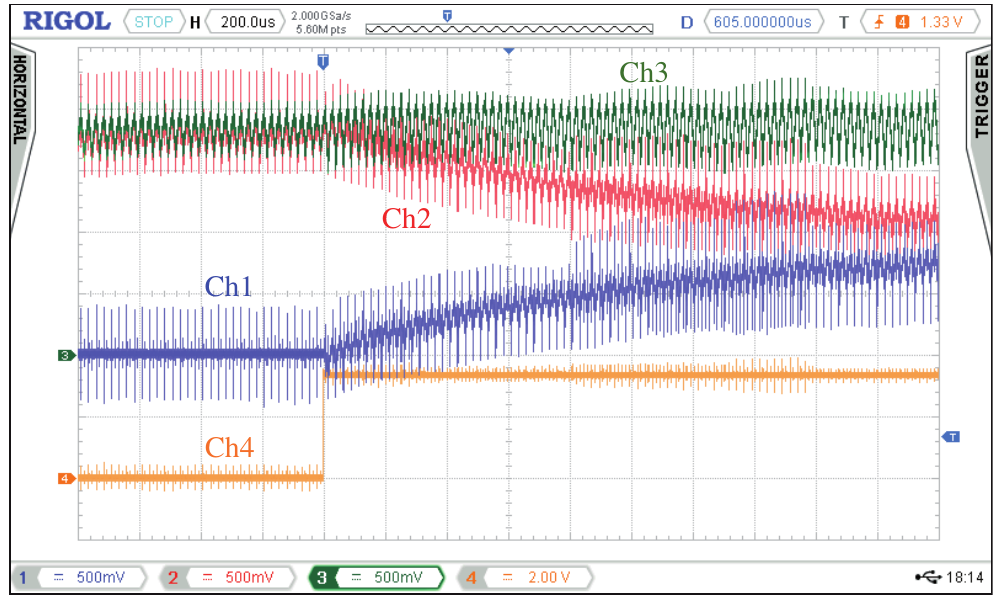
Figure 19. Converter 1 turn-on and current sharing with converter 2 using droop correction. Ch1: converter 1 output current (5 A/div). Ch2: converter 2 output current (5 A/div). Ch3: total output current (5 A/div). Ch4: synchronism digital